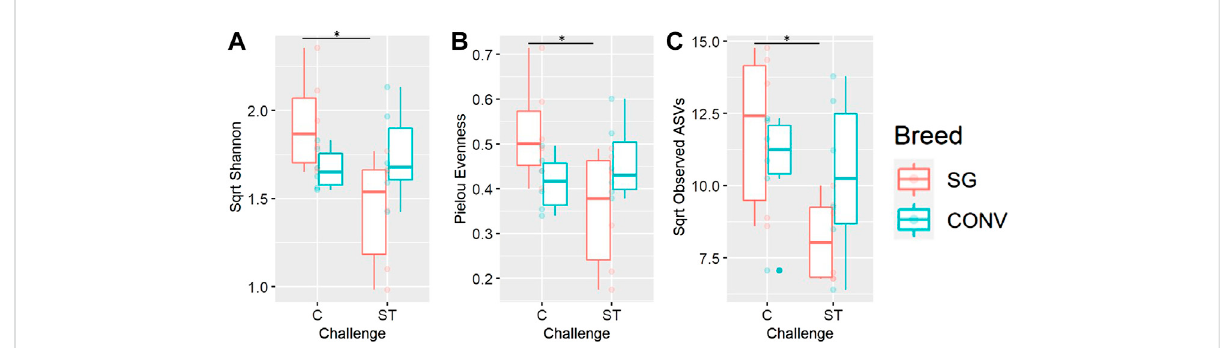
FIGURE 10 Theinteractionbetweenofgeneticlineand Salmonella challengeontheilealShannondiversity (A) ,Pielouevenness (B) ,andobservedamplicon sequence variant (ASV) richness (C) for 21-day-old broilers. The presence of an asterisk indicates a signi fi cant difference between pairwise groups in which *correspondsto p < 0.05, ** corresponds to p < 0.01, and *** corresponds to p < 0.001. Control (C) and Salmonella Typhimurium challenged (ST)